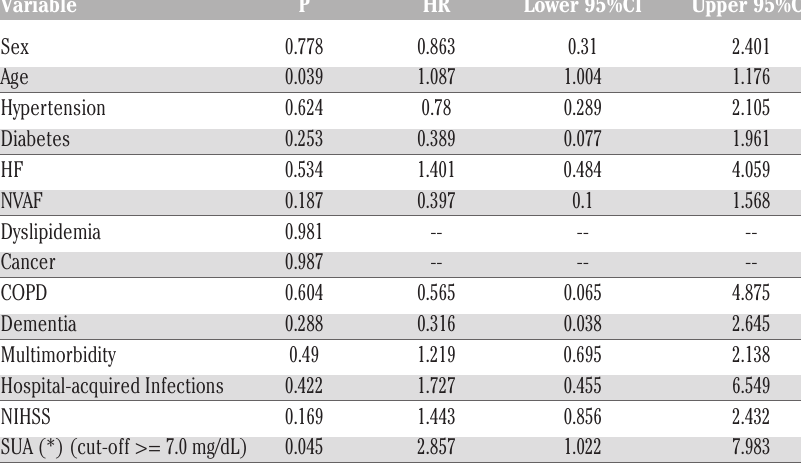
Table 2. Multivariate Cox regression analysis in the overall sample.